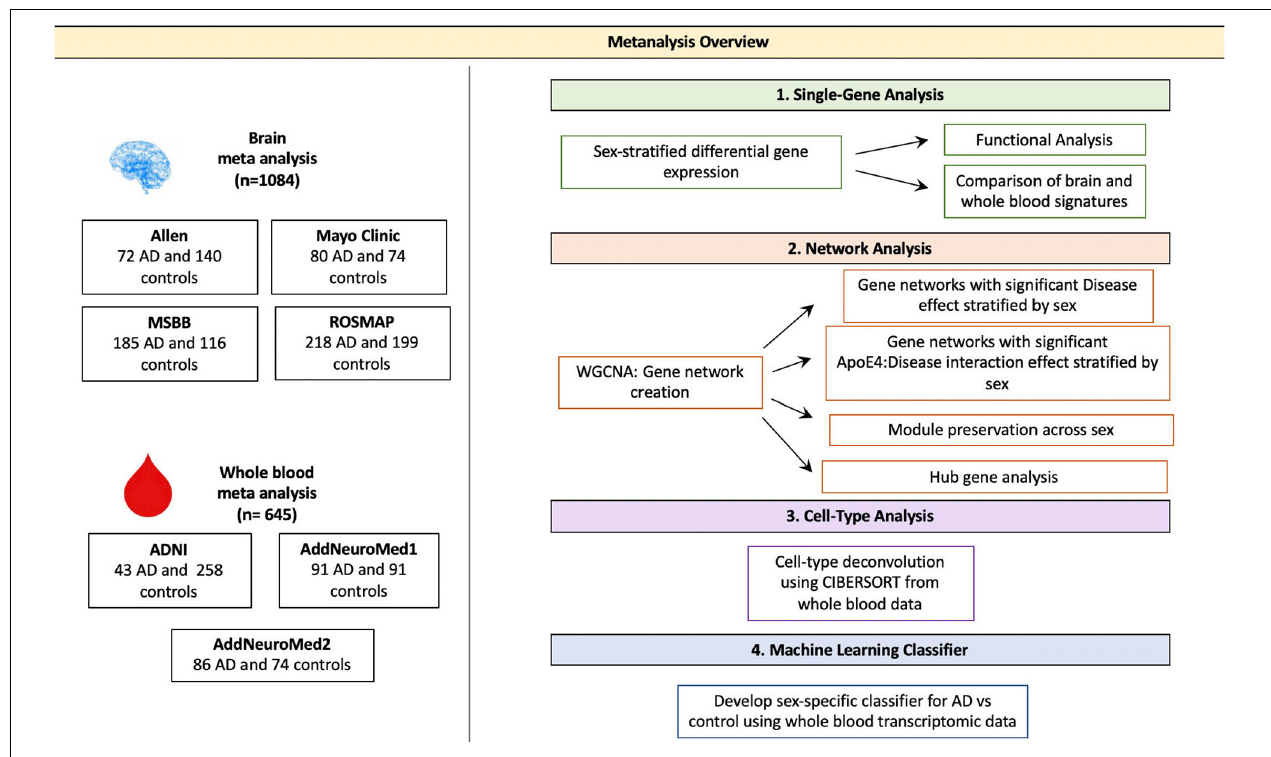
FIGURE 1 | Meta-analysis overview. Diagram depicting the study overview including all datasets used and analyses performed. Data sets were obtained via searching GEO or PubMed for the keyword Alzheimer’s Disease. Samples with neurological conditions other Alzheimer’s, including Parkinson’s Disease and Huntington’s Disease, and single cell preparations were excluded from analysis. Datasets were merged using the ComBat package in R. WGCNA was used for network analyses. CIBERSORT was used for cell type deconvolution. The linear SVM was trained to classify AD and control patients using the transcriptomic signature obtained via meta-analysis of blood studies. The performance of a molecular model consisting of gene expression, age, sex and APOE ε 4 status was compared to that clinical model with age, sex and APOE ε 4 status as